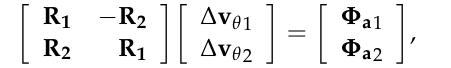
× M complex-valued 2 2